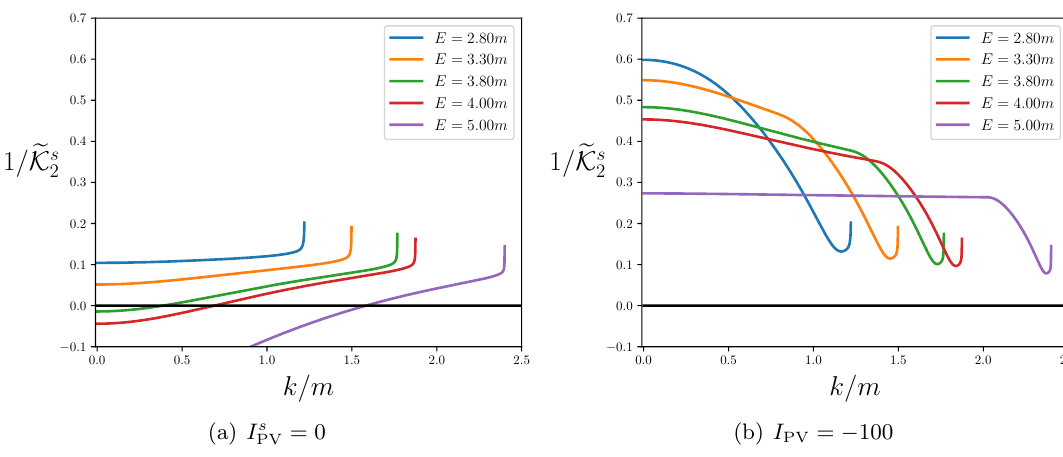
Figure 3 . 1 = e K s vs j ~k j =m , with ~k the spectator momentum for the Breit-Wigner form of the phase 2 shift given in eq. (2.10), with the resonance parameters set to g = 1 and m R = 2 : 7 m . Thus the resonance only leads to a zero crossing for E > 3 : 7 m . Results are shown for (a) I s I s = (cid:0) PV